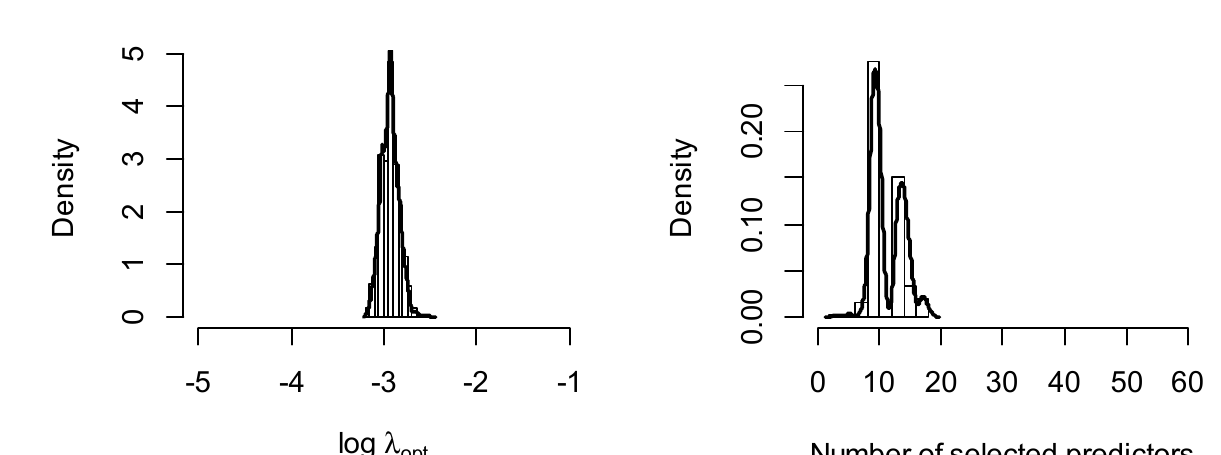
Figure 5. Distribution of λ opt ( A ) across 100 replicated runs of MCglmnet ( s = 50) is shown, along with the distribution of the corresponding number of predictors in the signatures ( B ). Comparison of